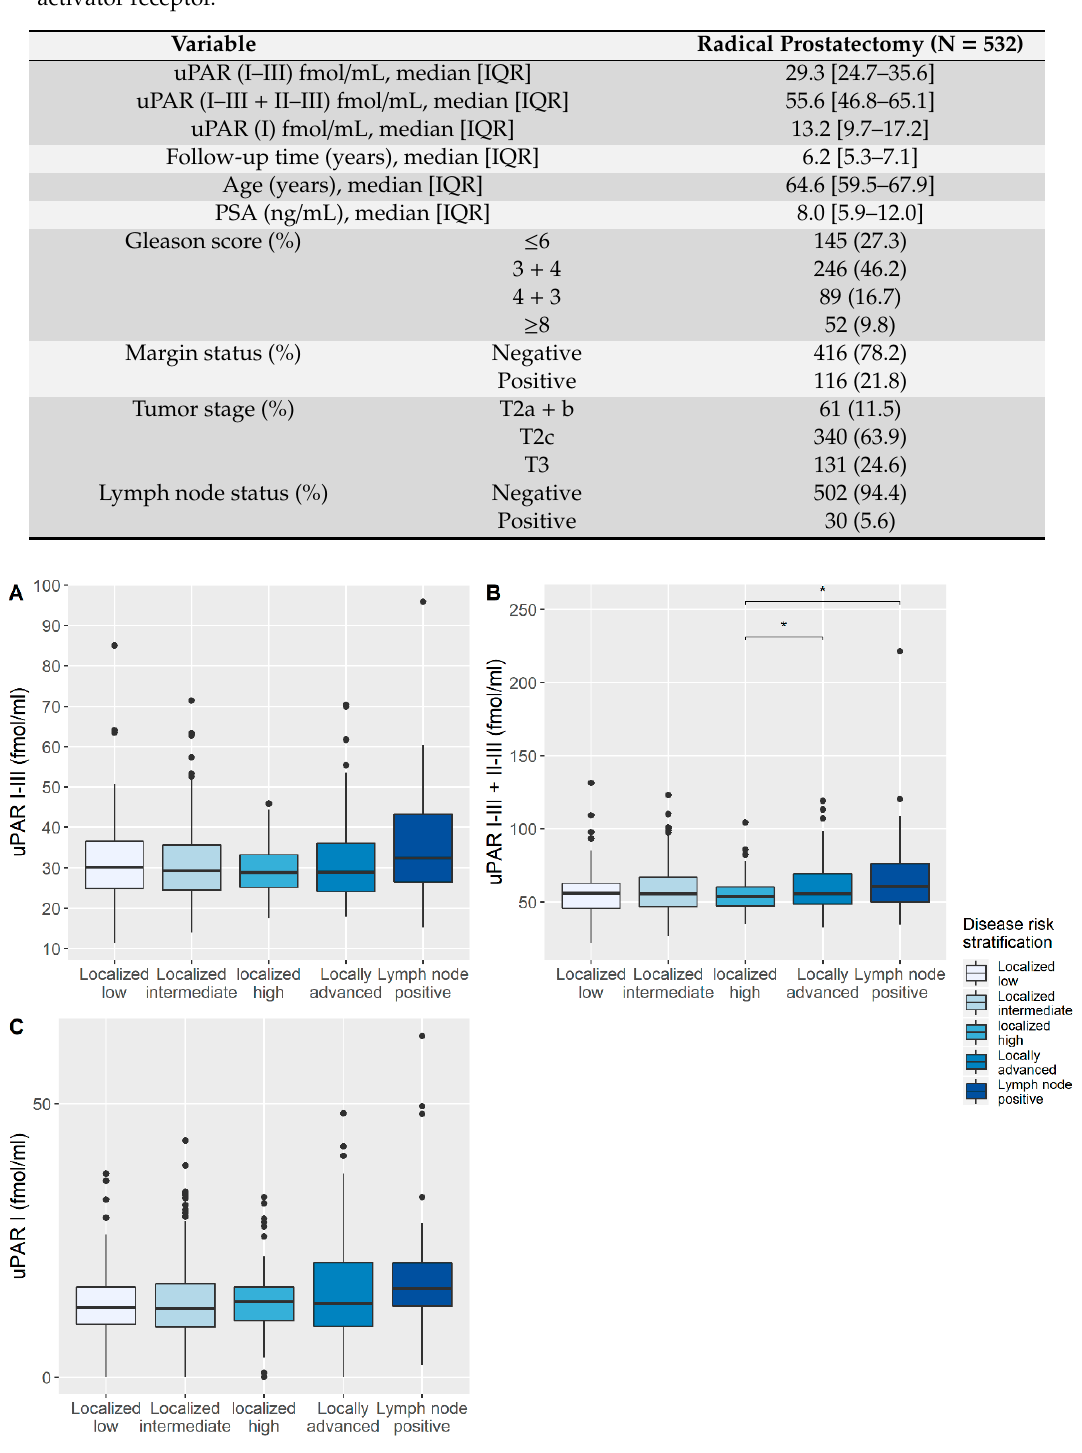
Figure 2. Distribution of plasma urokinase plasminogen activator receptor (uPAR) levels for disease risk stratification. ( A ) plasma uPAR I-III measurements, ( B ) plasma uPAR I–III + II–III measurements and ( C ) plasma uPAR I measurements. Box center represents the median, the box edges the interquartile range (IQR) and the whiskers are drawn until the last remaining value within 1.5 * IQR, dots are individual measurements outside this range. Significance was determined by ANOVA with post-hoc Welch two sample T-test for A and B and by Kruskal-Wallis rank sum test with post-hoc Wilcoxon rank sum test for C with * p ≤ 0.05.